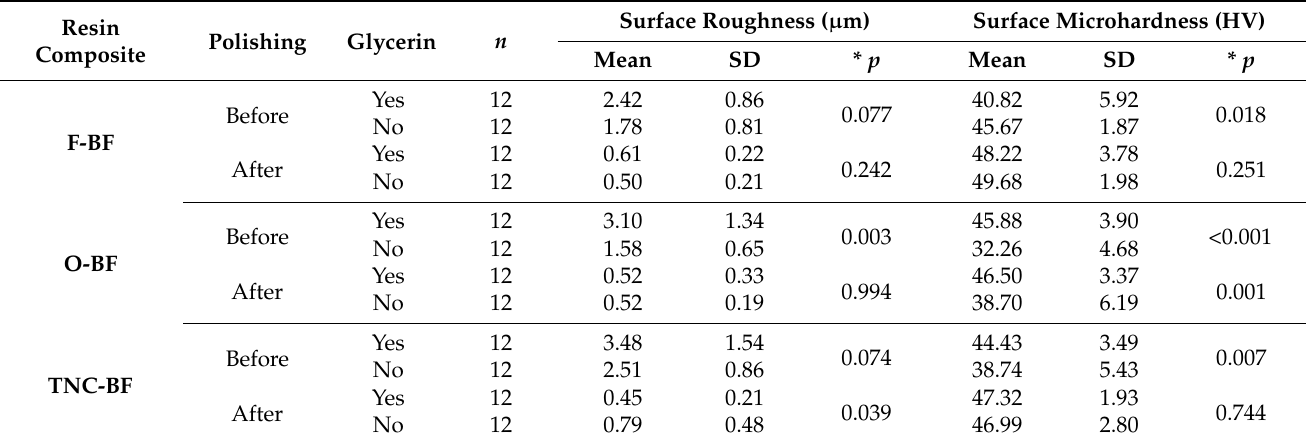
Table 5. Comparison of surface roughness (µm) and microhardness (HV) between before and after polishing of bulk-fill resin composites with and without OIL control.